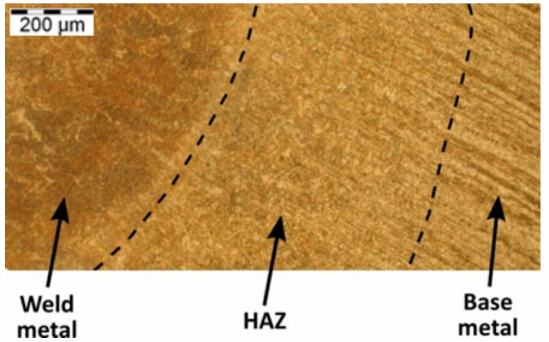
Figure 6. Three regions of samples welded without heat treatment: the base material, heat-affected zone (HAZ) and the weld region.